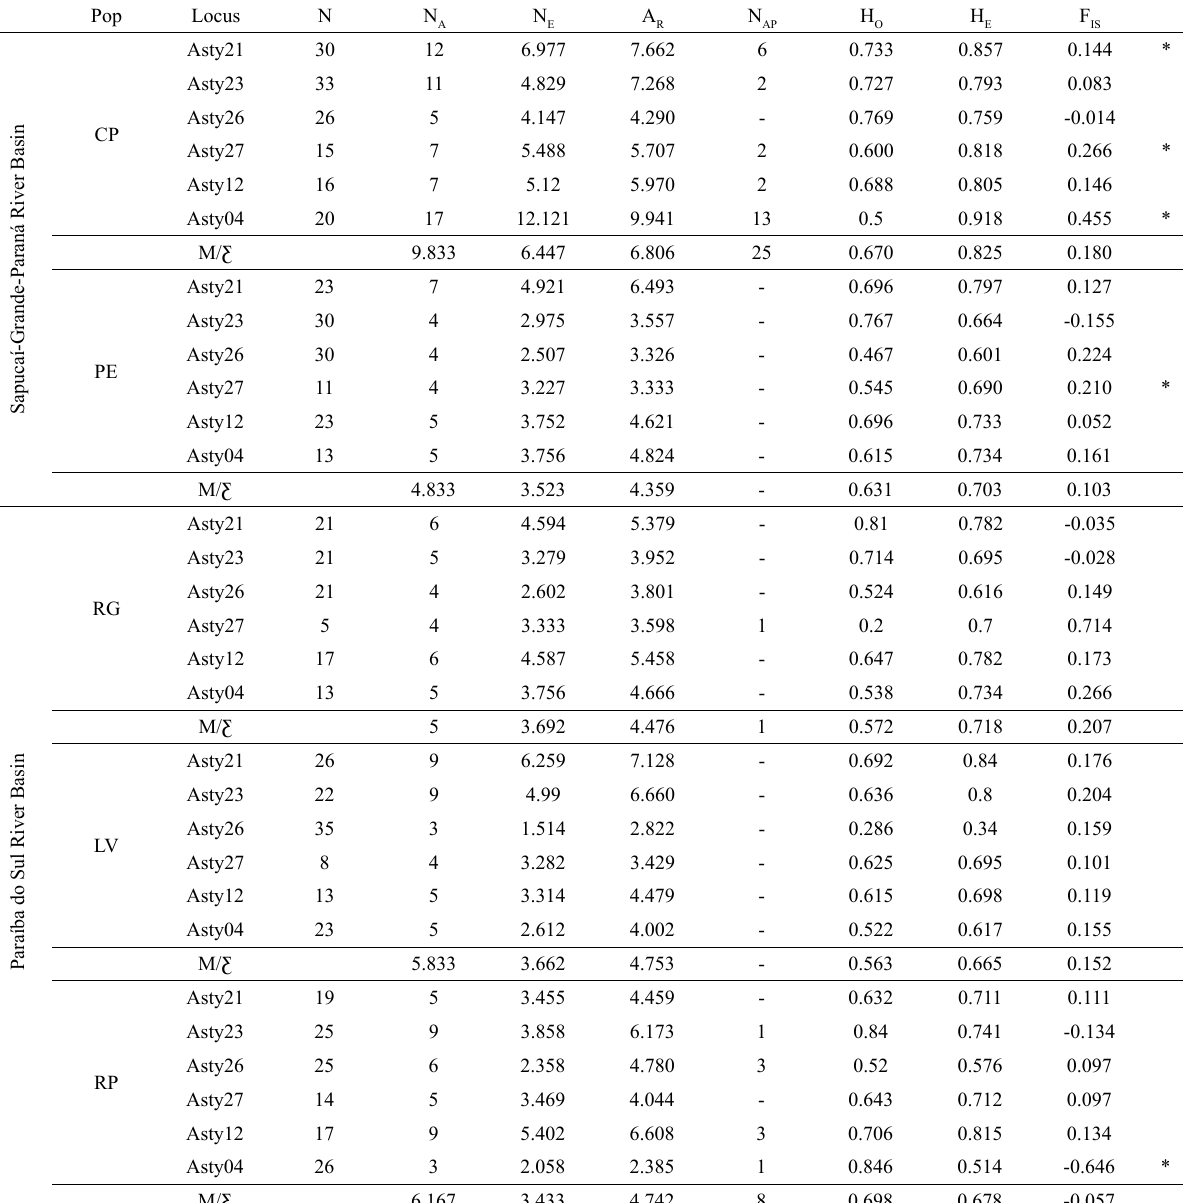
Table 2 – Genetic diversity parameters of five Psalidodon scabripinnis populations in the Sapucaí and Paraíba do Sul River basins, Serra da Mantiqueira region. Pop Locus